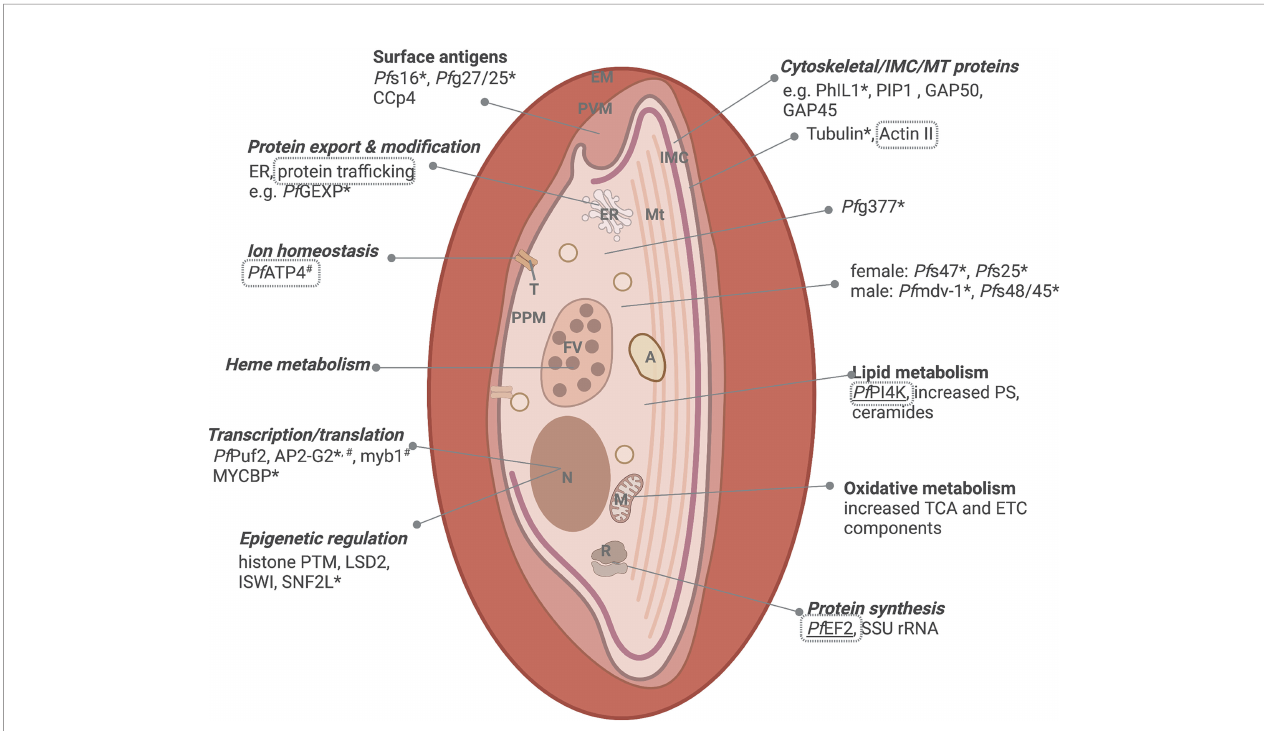
FIGURE 2 | Important biological processes of immature gametocytes. Immature gametocytes require extensive transcriptional reprogramming, metabolic adaptations, and ultrastructural changes. Processes with evidence of targetability is indicated either through genetic validation of essentiality (*essential to gametocytes, # essential to ABS, www.phenoPlasm.org; those genes refractory to manipulation indicating essentiality are underlined) or by chemical inhibition (grey text borders) and those shared with ABS are indicated in italics. EM, erythrocyte membrane; PVM, parasitophorous vacuolar membrane; IMC, inner membrane complex; ER, Endoplasmic reticulum; Mt, microtubular network; A, acidocalcisome; T, transporter; PPM, parasite plasma membrane; FV, food vacuole; N, nucleus; M, mitochondrion and R, ribosome. Protein names are explained in text. Created and modi fi ed with